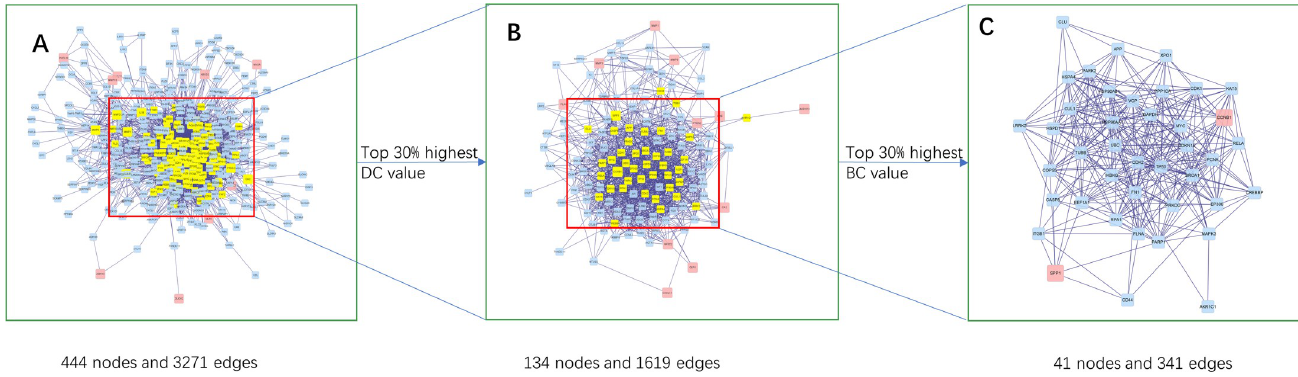
Fig 5. Topological analysis of the protein-protein interaction network. (A) The PPI network of XCHT-CRC target genes. (B) The PPI network of significant proteins extracted from A. (C) The PPI network of crucial XCHT targets for CRC treatment extracted from B.